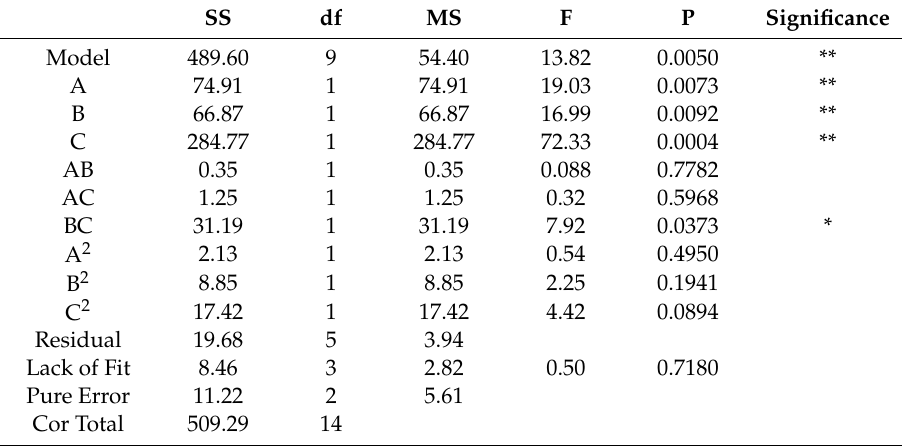
Table 4. Analysis of variance of quadratic polynomial regression